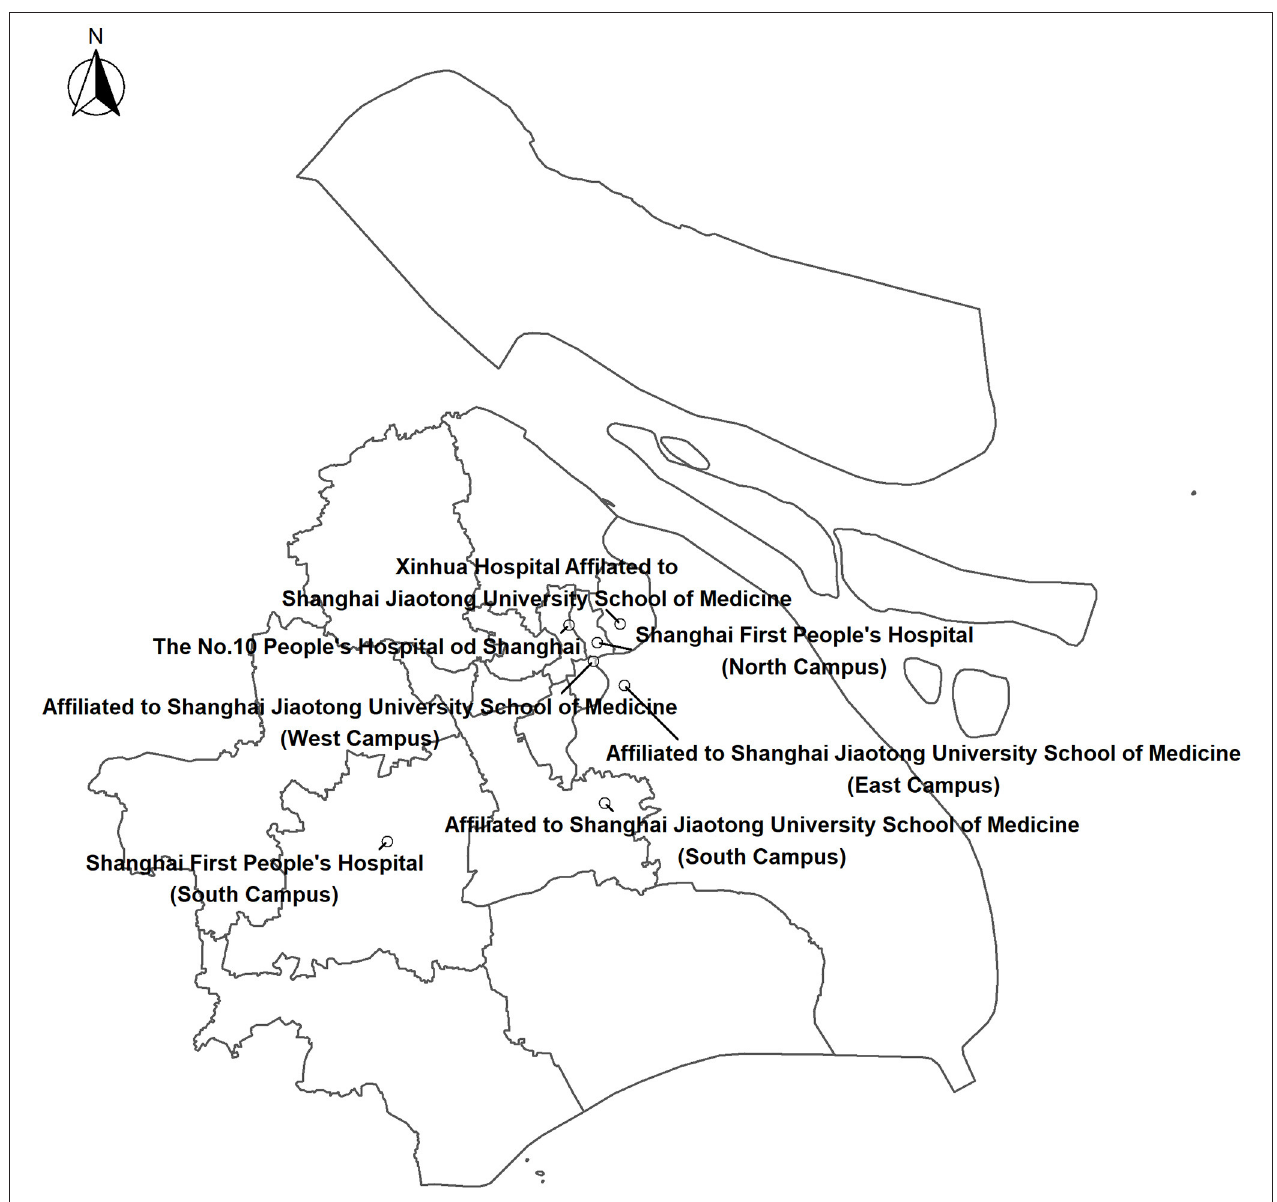
FIGURE 1 | Locations of four tertiary hospitals in